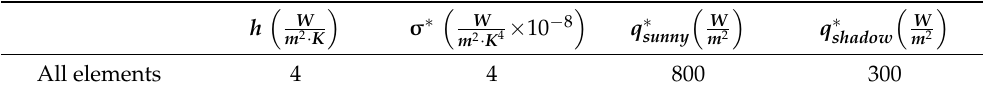
Table 3. The heat source, convection and radiation parameters of the wall in the case of sur- face area [36].